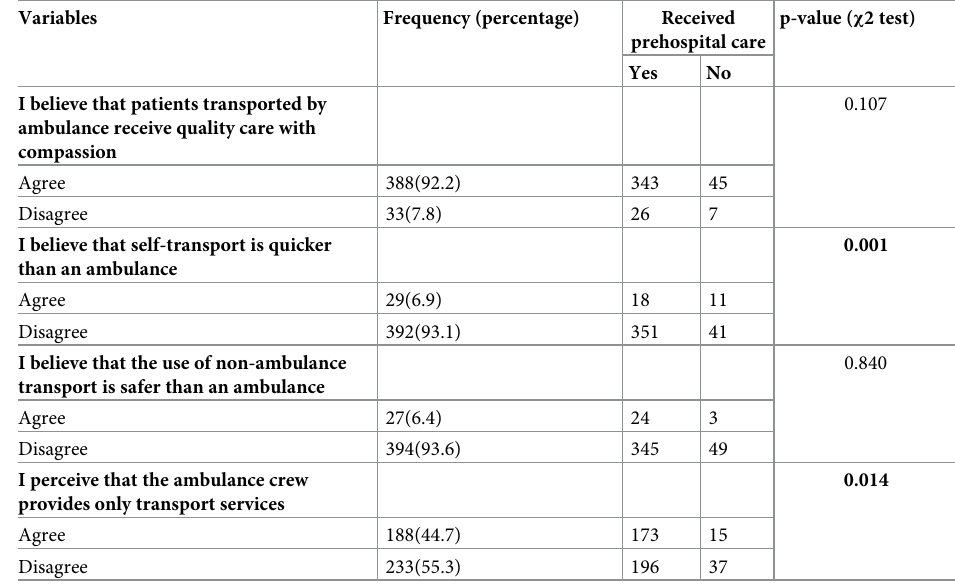
Table 3. Description of participant beliefs (predisposing characteristics) by prehospital care utilization among severe and critical COVID-19 patients who visited treatment centers in Addis Ababa, Ethiopia, from May to July 2021.